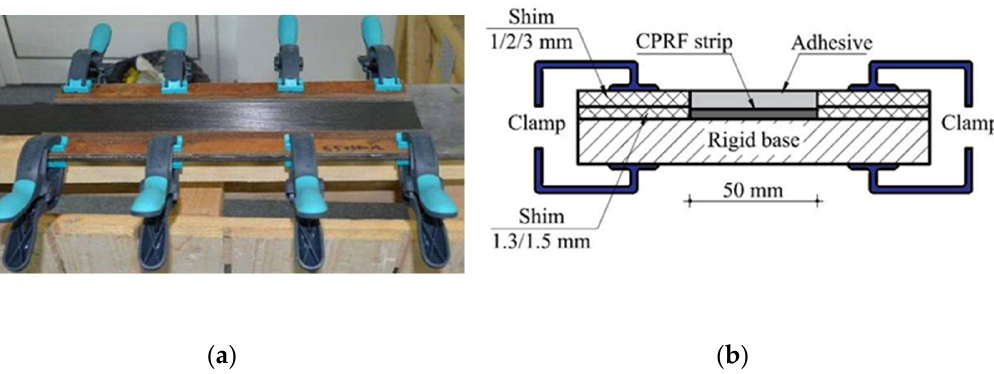
Figure 2. Rig for control of the adhesive thickness. ( a ) Laboratory setup, ( b ) Designed rig. Each specimen was marked with a code (i.e., S1 – S512-330-1-II), indicating the type of the CFRP composite strip, the type of adhesive and its thickness. The last term stands for identifying specimens with identical configurations. The general layout of the specimens